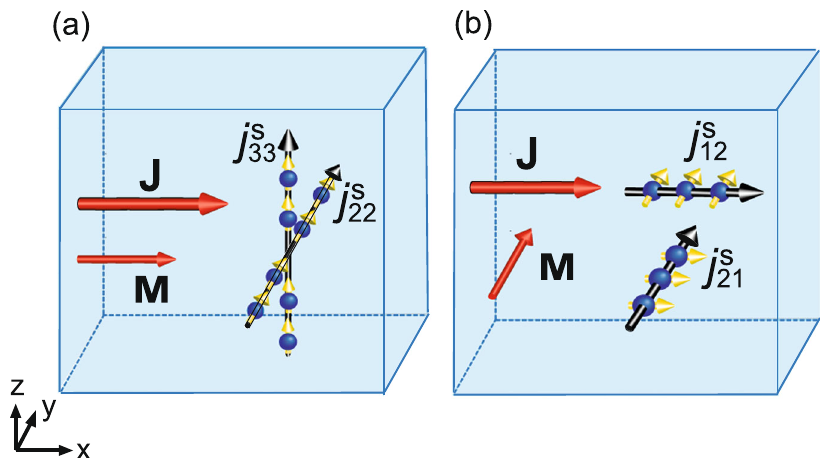
Fig. 1 Schematics of anomalous spin Hall effect. a The charge current J (the thicker red arrowed line) and magnetization M (the thinner red arrowed line) are along the x direction. Two anomalous spin current j s and j s (the black arrowed lines) proportional to M (magnitude of M ) and J (magnitude of J ) are 22 33 generated. b The charge current J (the thicker red arrowed line) and magnetization M (the thinner red arrowed line) are respectively along the ^ x and the ^ y directions. Two spin currents j s and j s (the black arrowed lines decorated with golden arrows) proportional to MJ are 12 21